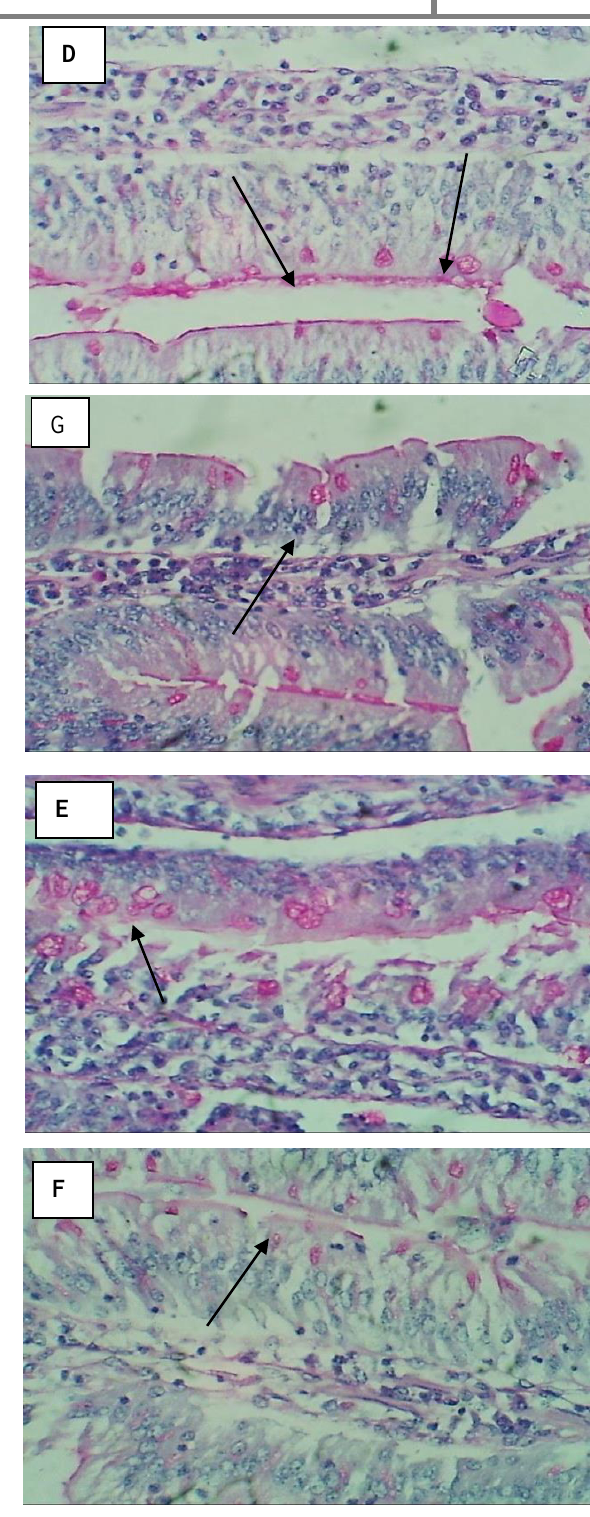
Figure 7. Light microscopic image of duodenum cross section, positive reaction color of goblet cells appeared red color with PAS in A(G1), B(G2), C(G3),D(G4), E(G5),F(G6) and G(G7). The arrow indicates to goblet